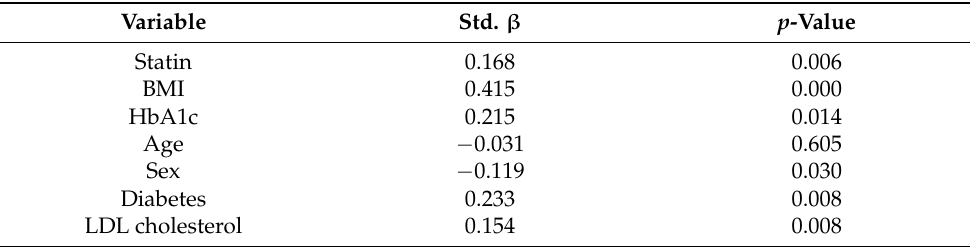
Table 4. Linear regression analysis for estimating the impact of statin treatment and LDL-cholesterol on HOMA-IR. All continuous variables and the outcome were